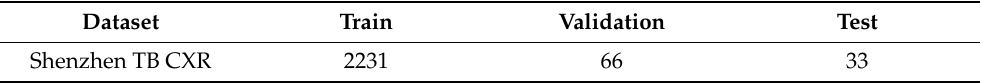
Table 1. Dataset and its respective patient-level train/validation/test